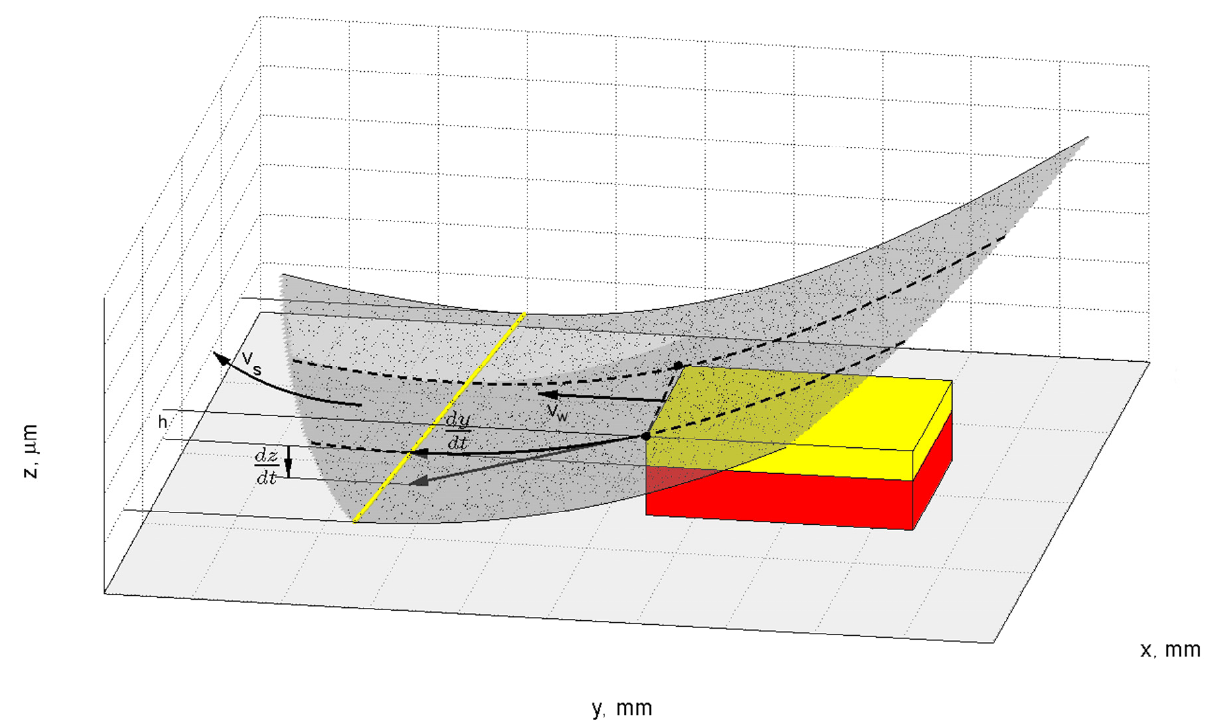
= dz (cid:3031)(cid:3053) . Figure 13. Graphical interpretation of the material removal speed v h dt (cid:3031)(cid:3047)